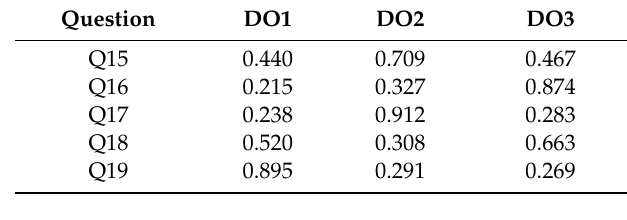
Table 4. Factor analysis questions about the BIM contribution and acquired skills: Factor pattern after varimax rotation.